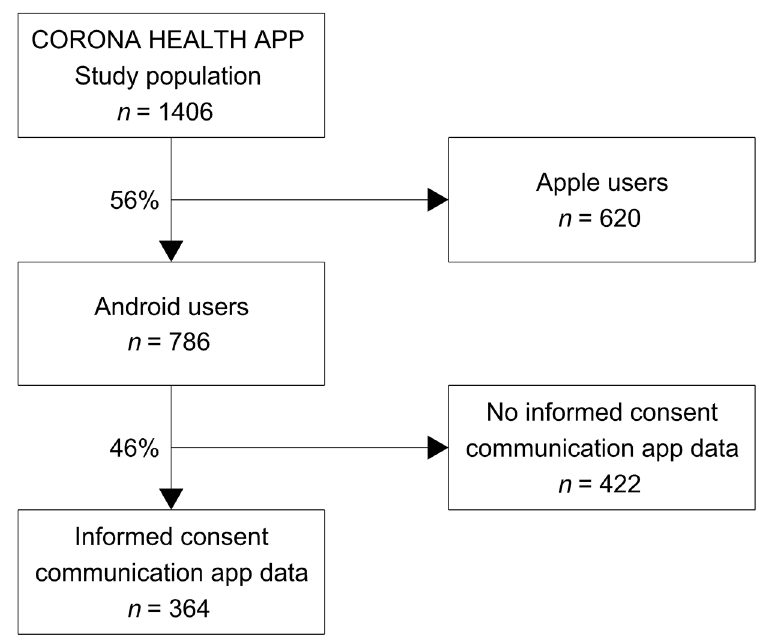
Figure 1. Flowchart of the current study’s sample composition.